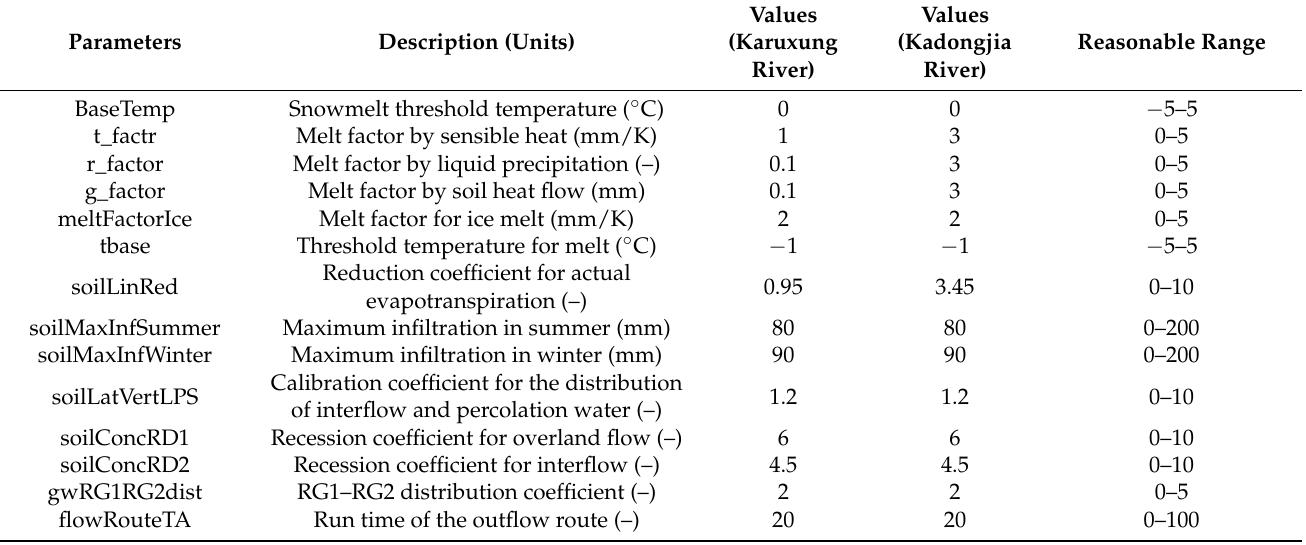
Table 3. Parameters used to simulate runoff in Karuxung and Kadongjia river catchments, Tibetan